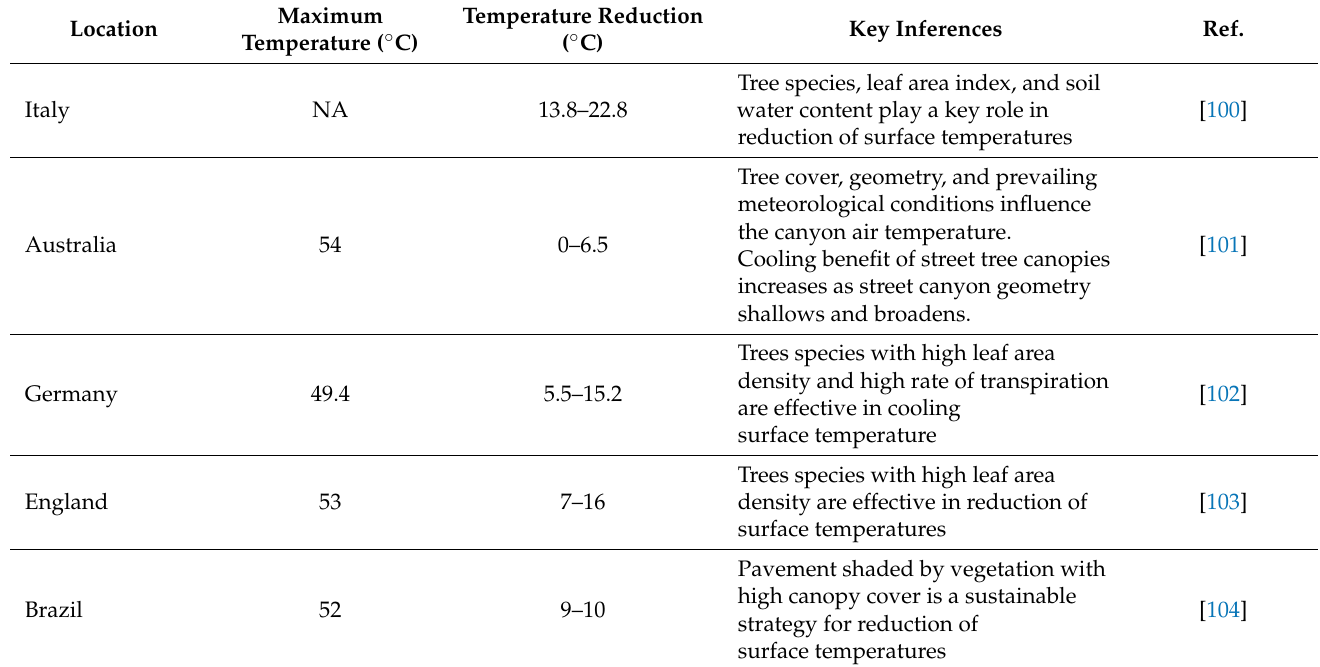
Table 4. Summary of global studies investigating the cooling effect of trees. Key Inferences